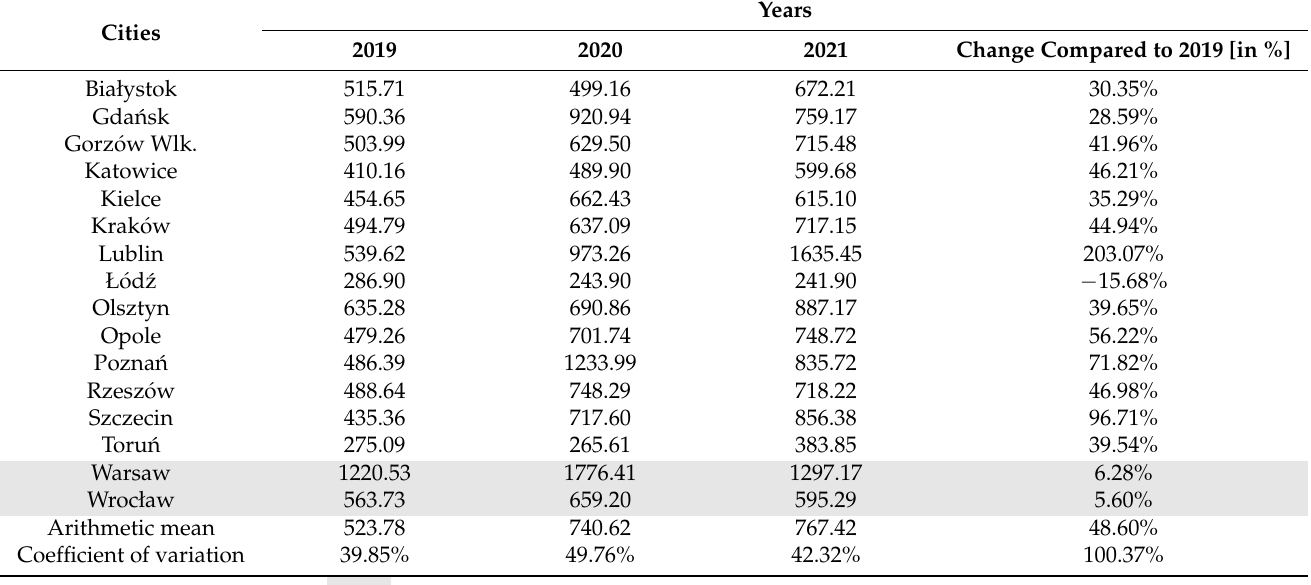
Table 4. Total cost-effectiveness of collected municipal waste services in the studied cities from 2019–2021 [in PLN/ton].